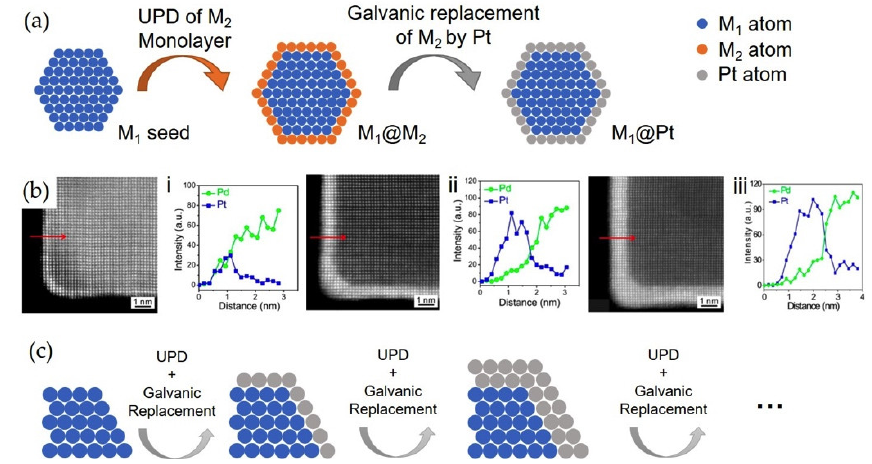
Figure 4. ( a ) Schematic illustration of underpotential deposition (UPD) coupled with galvanic replacement to fashion a well-defined Pt monolayer skin; ( b ) High angle annular dark field scanning transmission electron microscopy (HAADF-STEM) images and the energy dispersive X-ray spectroscopy (EDS) line scan along the red arrows taken from the Pd@Pt nanocubes with i. one Pt atom layer, ii. four Pt atom layers, and iii. six Pt atom layers. Reprinted with permission from reference [63]. Copyright 2014 American Chemical Society; ( c ) Schematic illustration of fabrication of Pt-skin with any number of layers.